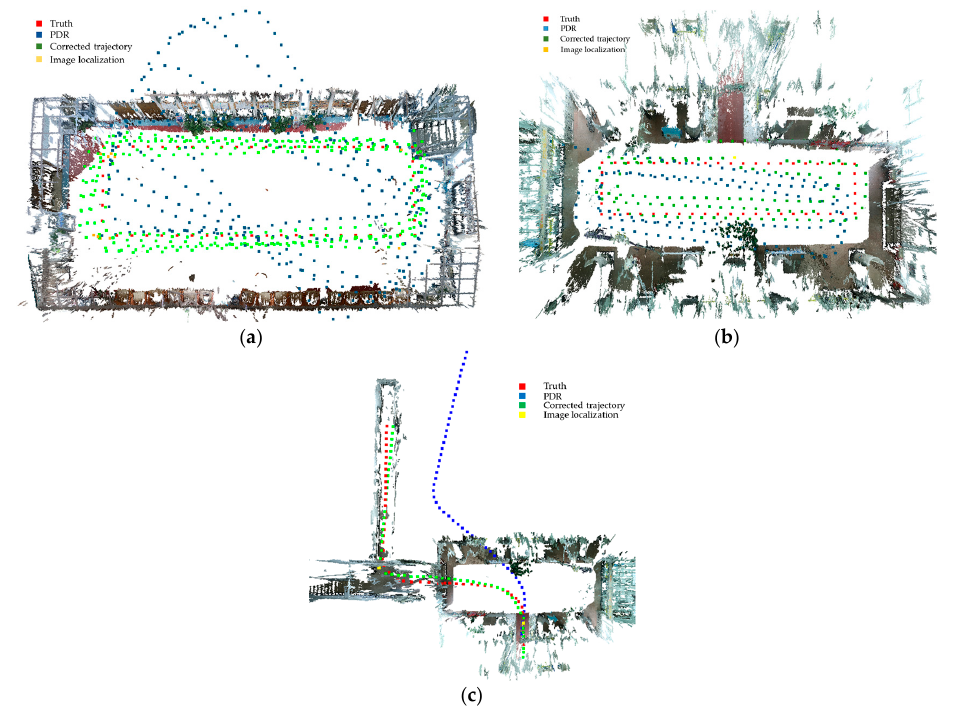
Figure 9. The localization results shown in the indoor environment: ( a ) The localization result for the meeting room dataset; ( b ) The localization result for the lobby dataset; ( c ) The localization result for the level-scale dataset in the lobby dataset.